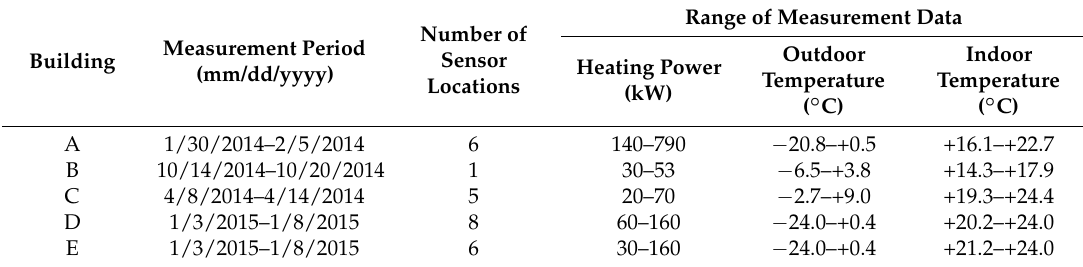
Table 2. Measurement period, the number of different locations for indoor temperature sensors and the range of power and outdoor and indoor temperature measurement.